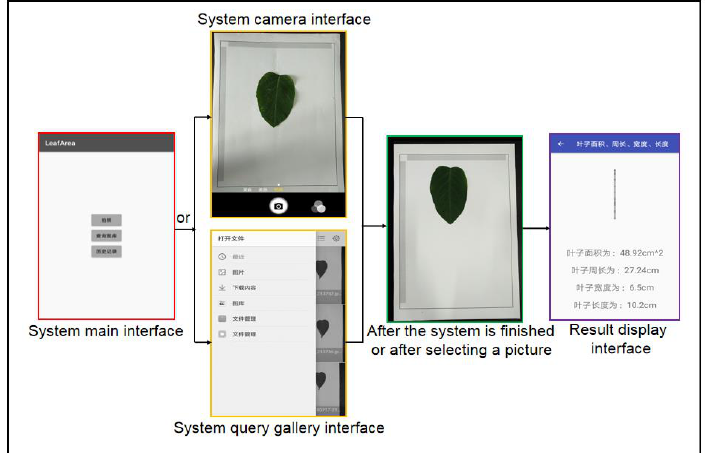
Figure 3. Running process of the software chart.